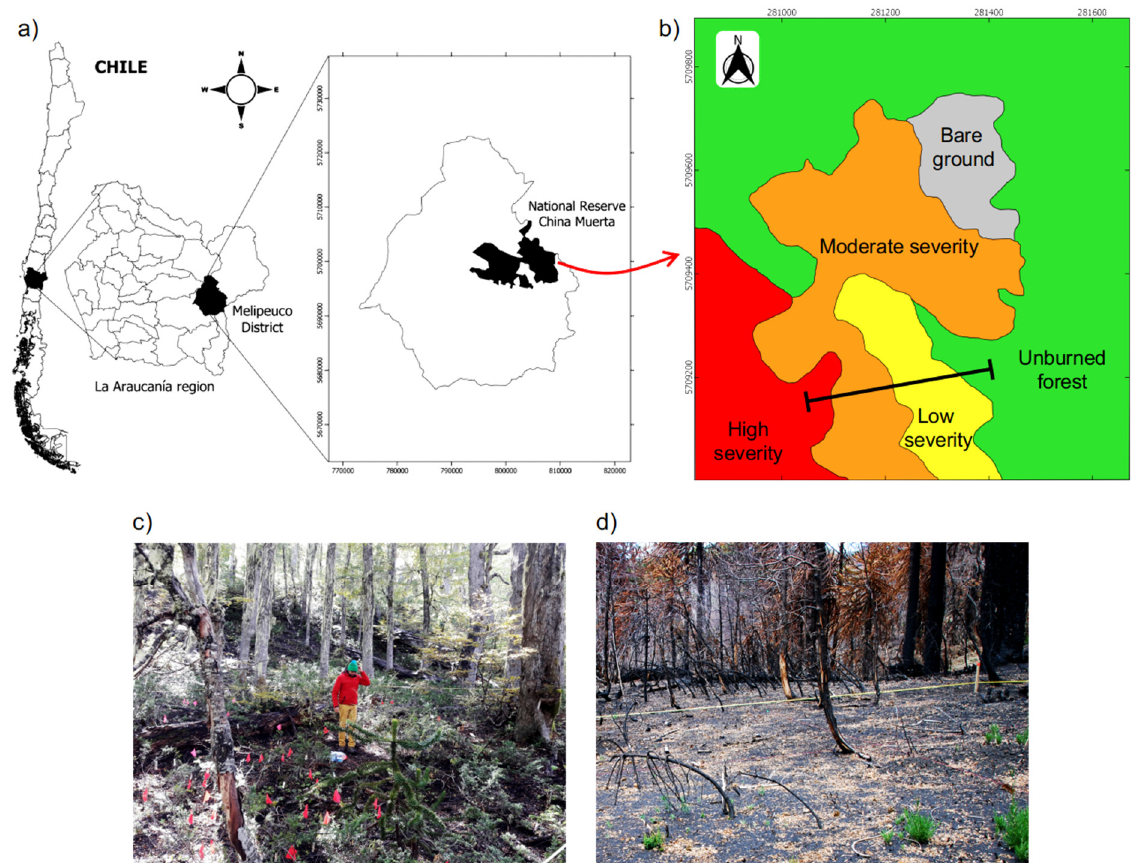
Figure 1. ( a ) Study area in the National Reserve China Muerta, La Araucanía region (38°S, 71°W), south-central Chile. ( b ) Map of the different levels of fire severity that affected the study area, and the location of the transect used to sample soil variables. ( c , d ) Pictures of the study sites showing the unburned forest and areas of high fire severity, respectively.